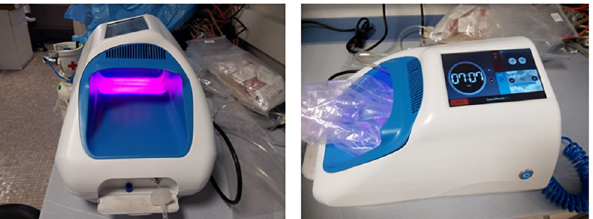
Fig 1. Equipment designed for the combined ozone and laser therapy of onychomycosis, showing the central irradiated chamber (left) where the bag receiving the ozone gas is placed (right).